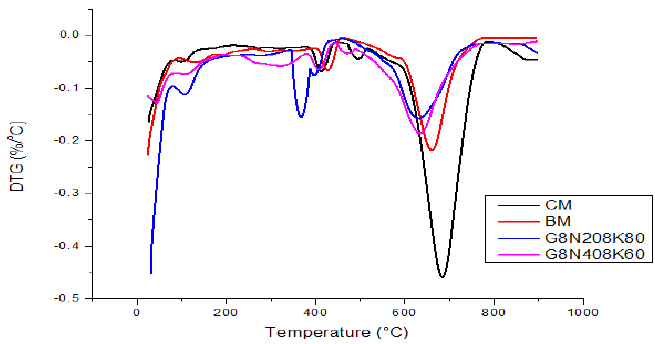
Figure 14. Derivative thermogravimetric (DTG) analysis of geopolymer concrete and control mixtures.